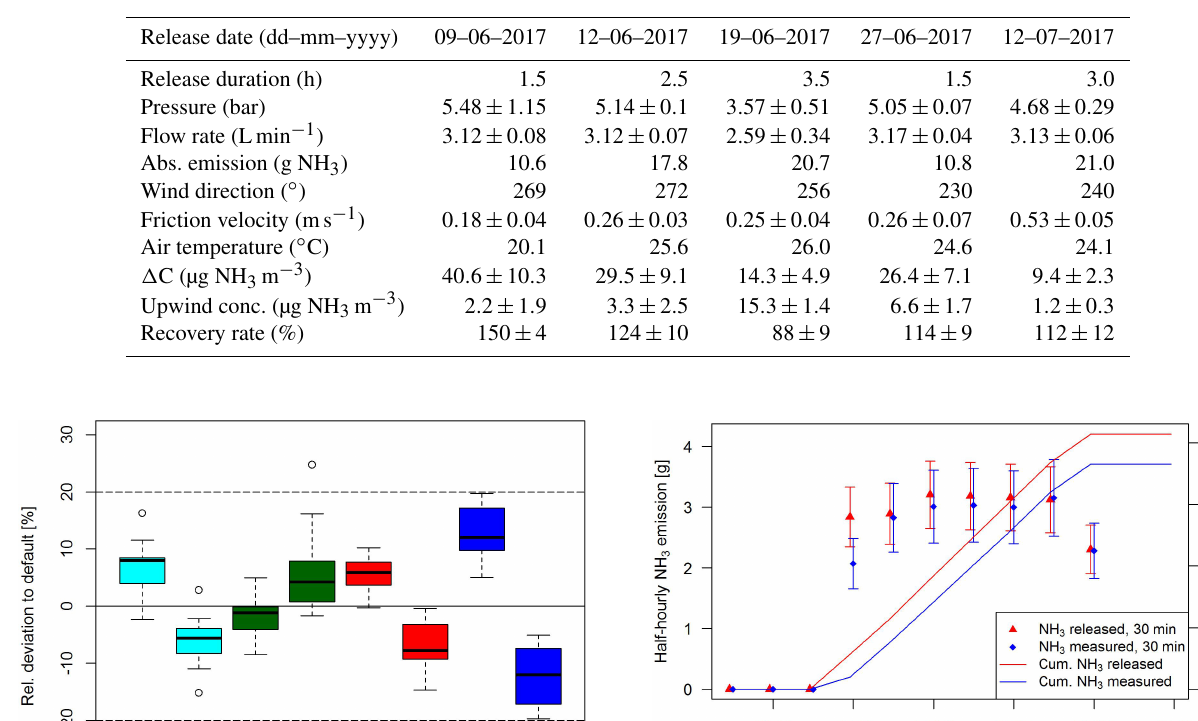
Table 4. Artificial source characteristics, environmental conditions, measured MD concentrations and recovery rates during the individual gas release experiments. Averaged values during the release periods are shown. For selected parameters, the standard deviation is given as well.